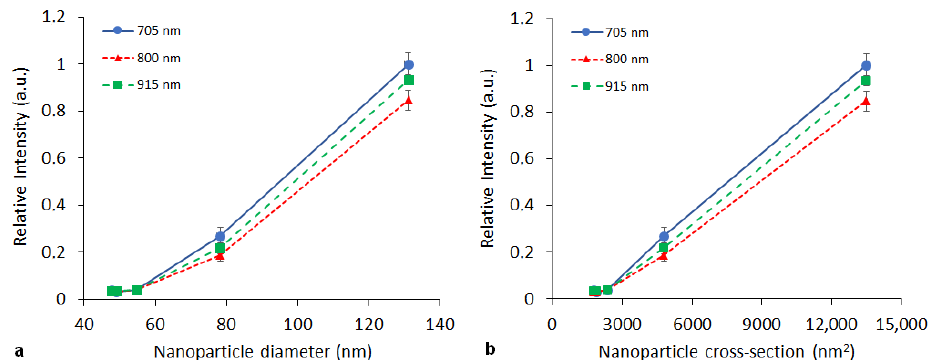
Figure 5. Dependence of the relative PA signal intensity (per one nanoparticle) on the nanoparticle diameter ( a ) or cross-sectional area ( b ) measured at the same concentration (3 mg/mL) at selected wavelengths (705, 800, 915 nm).